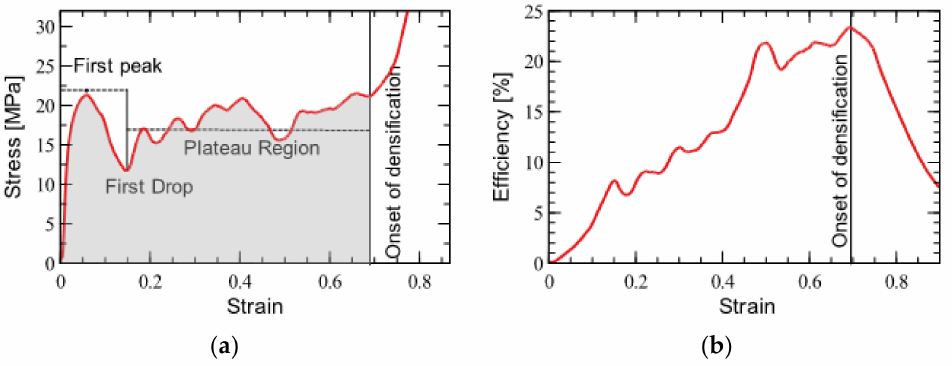
Figure 1. ( a ) a typical compression stress–strain response of a metallic lattice material showing the first peak, the plateau region, and the onset of densification, and ( b ) energy efficiency graphed against displacement, with the peak used to identify the onset of